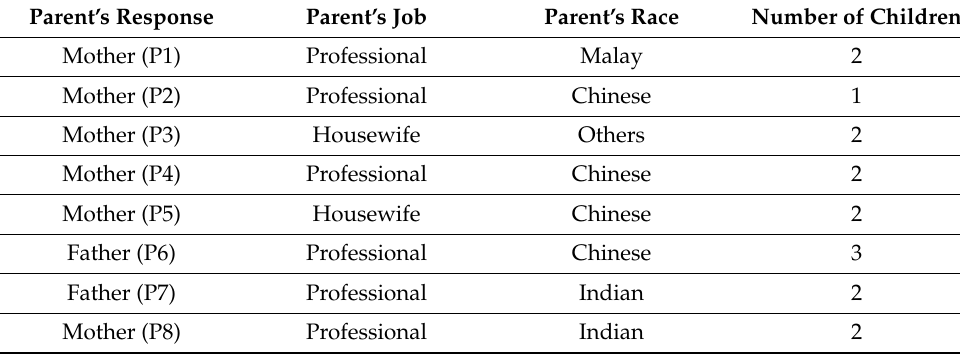
Table 1. Demographic Characteristics of